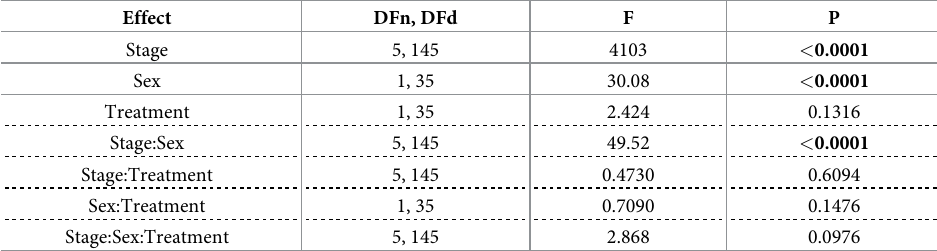
Table 2. ANOVA output of stage-specific body lengths linear mixed effects model.